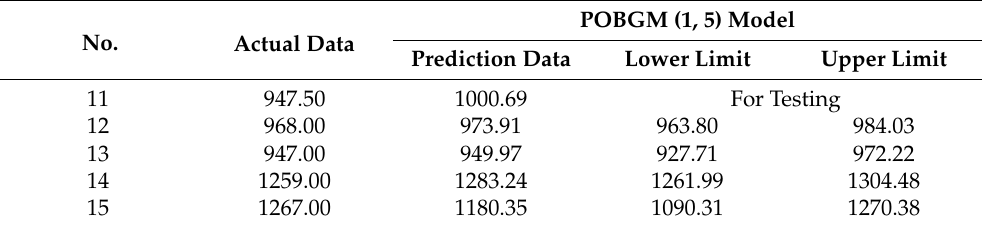
Table 8. Prediction interval of MSW’s HHVs at 95% PI (kcal · kg − 1